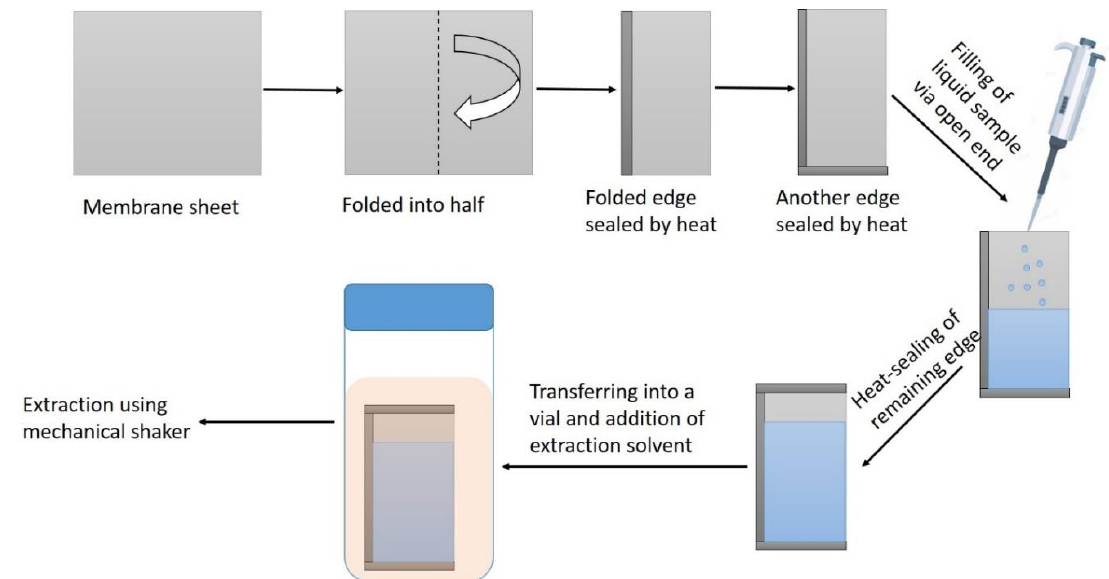
Figure 1. Schematic of membrane-based inverted liquid–liquid extraction (MILLE).